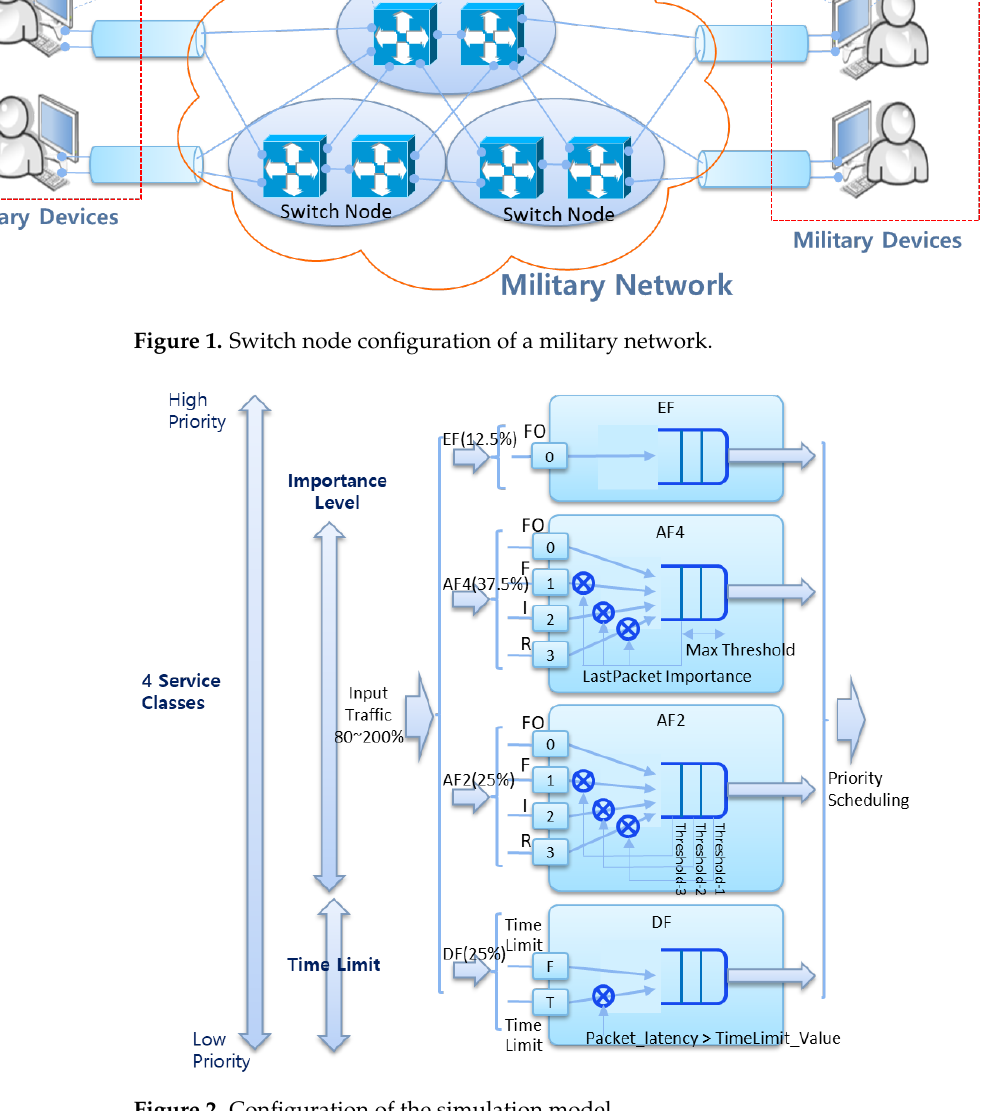
Figure 2. Configuration of the simulation model.